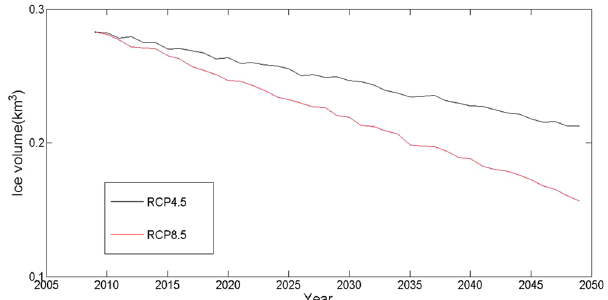
Figure 11. Glacial volume changes from 2009 to 2049 based on the RCP 4.5 and RCP 8.5 climate modes.